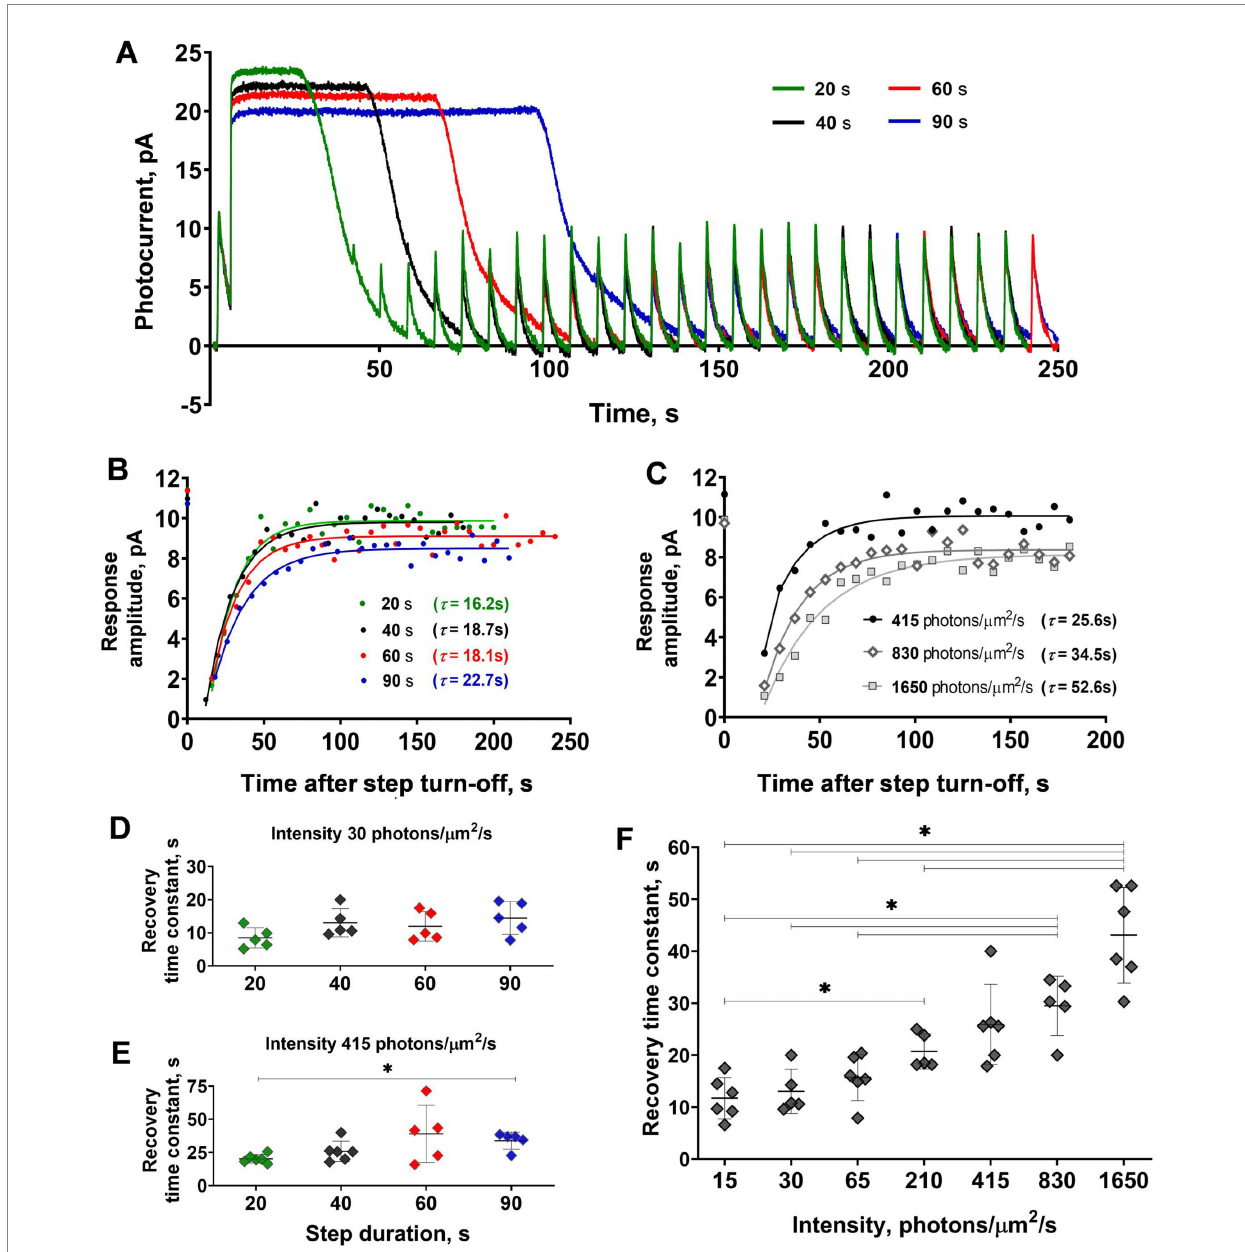
FIGURE 3 Comparison of the sensitivity recovery rate after light steps of increasing duration and intensities. (A) Responses of the representative isolated frog rod to stimulation with a combination of saturating light exposure steps of different durations and the same 2 ms light stimuli (every curve averaged from 2–5 records obtained under the same protocol conditions and smoothed with moving average filter with a 40 ms window). Black line –40 s step; green –20 s step; red –60 s; and blue –90 s step. (B) Dynamics of response amplitudes after steps from panel A. (C) Dynamics of response amplitudes after 40 s steps of four different intensities (210, 415, 830, and 1,650 photons· μ m − 2 ·s − 1 ). In panels (B) and (C) for reference, the point plotted at time zero illustrates the pre-step value. Changes in step duration do not affect the time course of current recovery for both moderate intensities (D) , while saturating intensity steps (E) show a significant difference between the 20 and 90 s illumination lengths. An increase in 40 s stimulus intensity leads to a significant slowdown in the current recovery (F) . Asterisk * indicates statistically significant differences between groups (Dunnett’s multiple comparisons tests; p < 0.05). Sample sizes n =